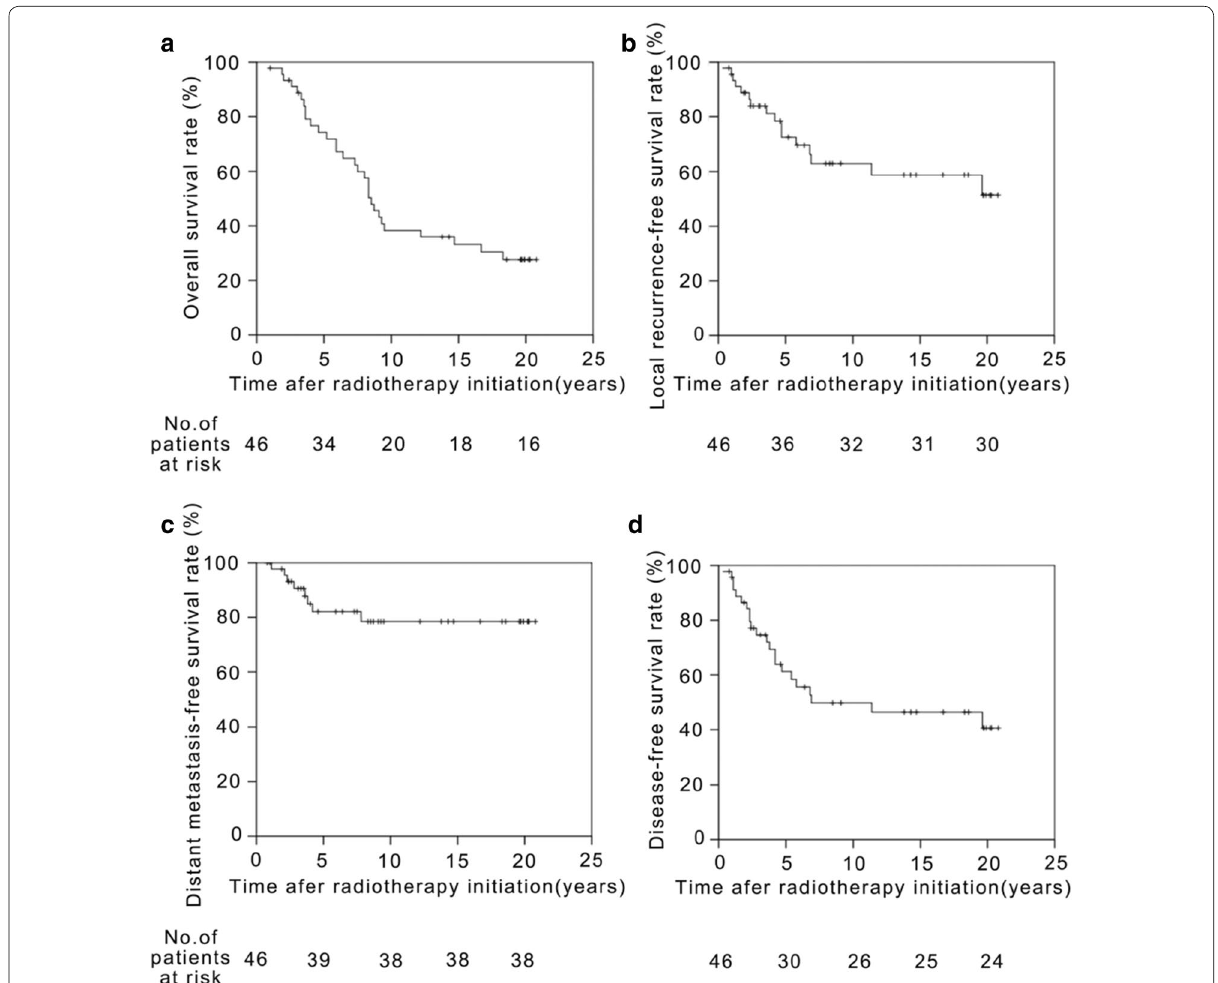
Fig. 2 The Kaplan–Meier estimated survival curves of the 46 patients with NPC. a overall survival; b local recurrence‑free survival; c distant metastasis‑free survival; and d disease‑free